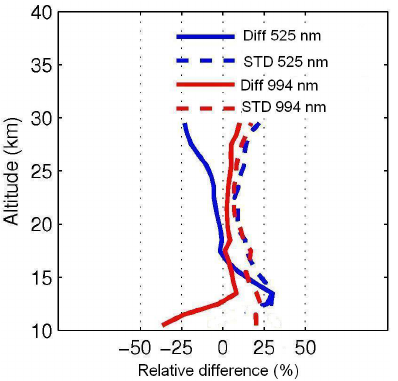
Fig. 3. Summary plot of the relative difference (percent) for all retrieved aerosol extinction profiles for the 450 simulated radiances. Blue 994nm, red 525nm. The dashed lines represent the standard deviations.